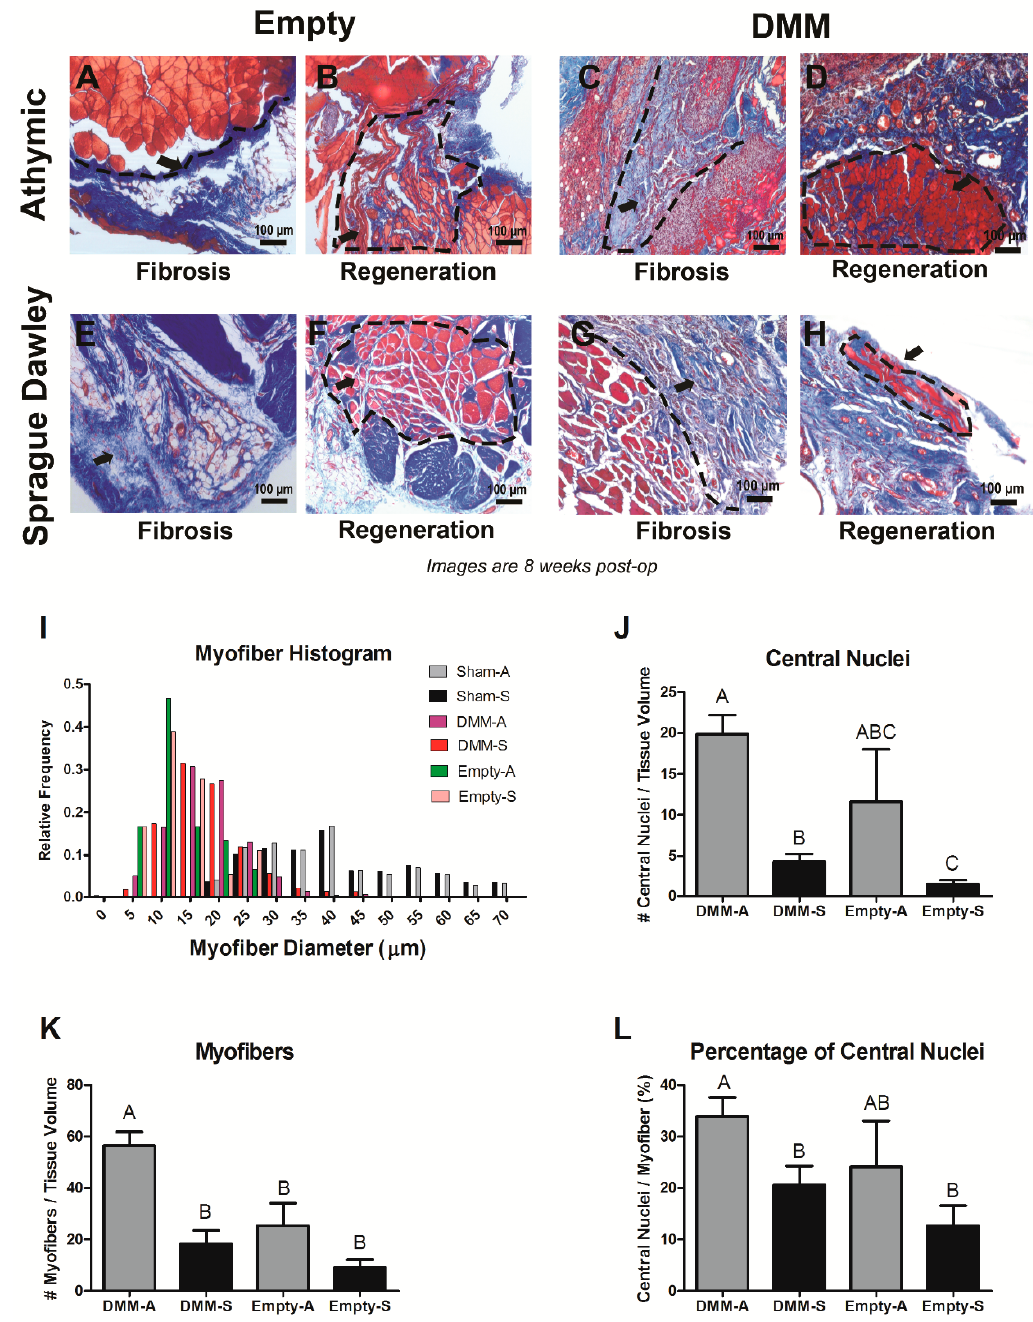
Figure 3. Histological staining and morphometric analysis for VML injuries in Sprague Dawley and RNU rats. Representative images demonstrate a fibrotic response following injury or DMM treatment ( A , C , E , G ), or regenerative response following injury or DMM treatment ( B , D , F , H ). Histomorphometry showed similar relative frequencies for myofibers in Sprague Dawley and RNU rats ( I ), increased central nuclei in DMM-treated RNU rats ( J ), increased myofibers in DMM-treated RNU rats ( K ), and increased percentage of central nuclei in RNU rats ( L ). Letters not shared indicate a significant difference ( p < 0.05, Tukey). Data shown are means ± SEM of 8 DMM and sham animals and ± SEM of 3 for empty defect animals.